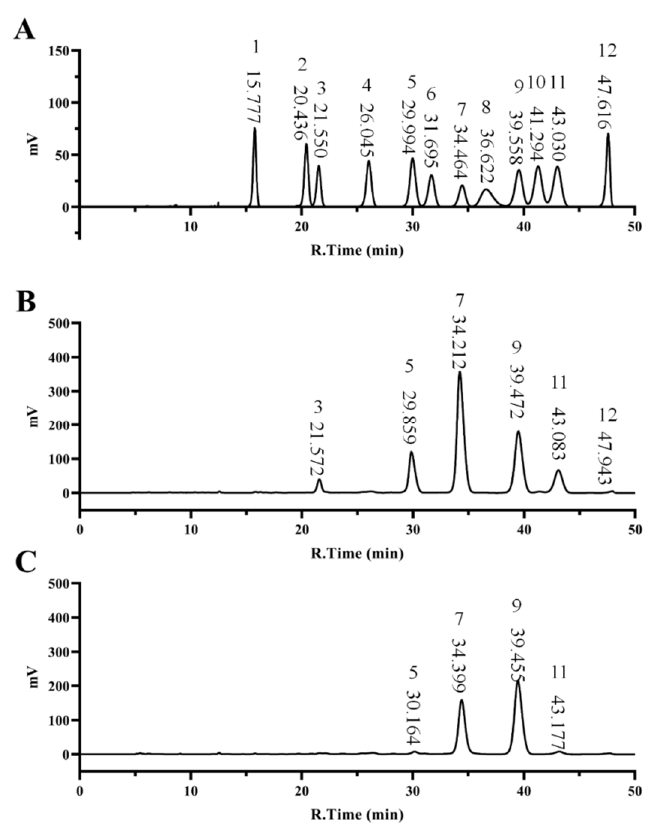
Figure 1. Monosaccharide composition of RGPs. Monosaccharide Standard Curve ( A ), RGP − 1 − A ( B ) and RGP − 2 − A ( C ). RGP − 1 − A: Rehmannia glutinosa polysaccharides decolorized by the AB-8 macroporous resin; RGP − 2 − A: Rehmannia glutinosa polysaccharides decolorized by H 2 O 2 .